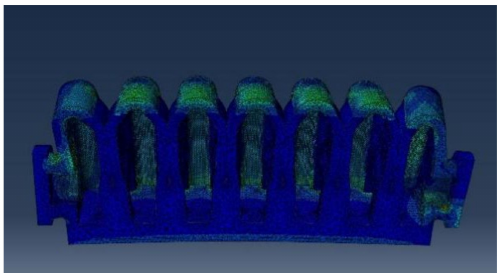
Figure 5. The cross-section view of stress distribution of the